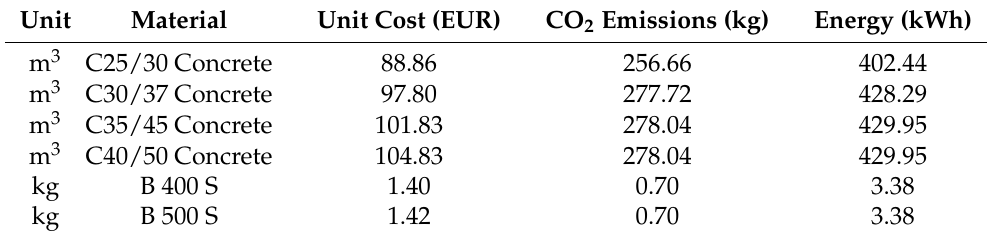
Table 1. Unit cost, associated CO 2 emission and embodied energy values for each material [29].